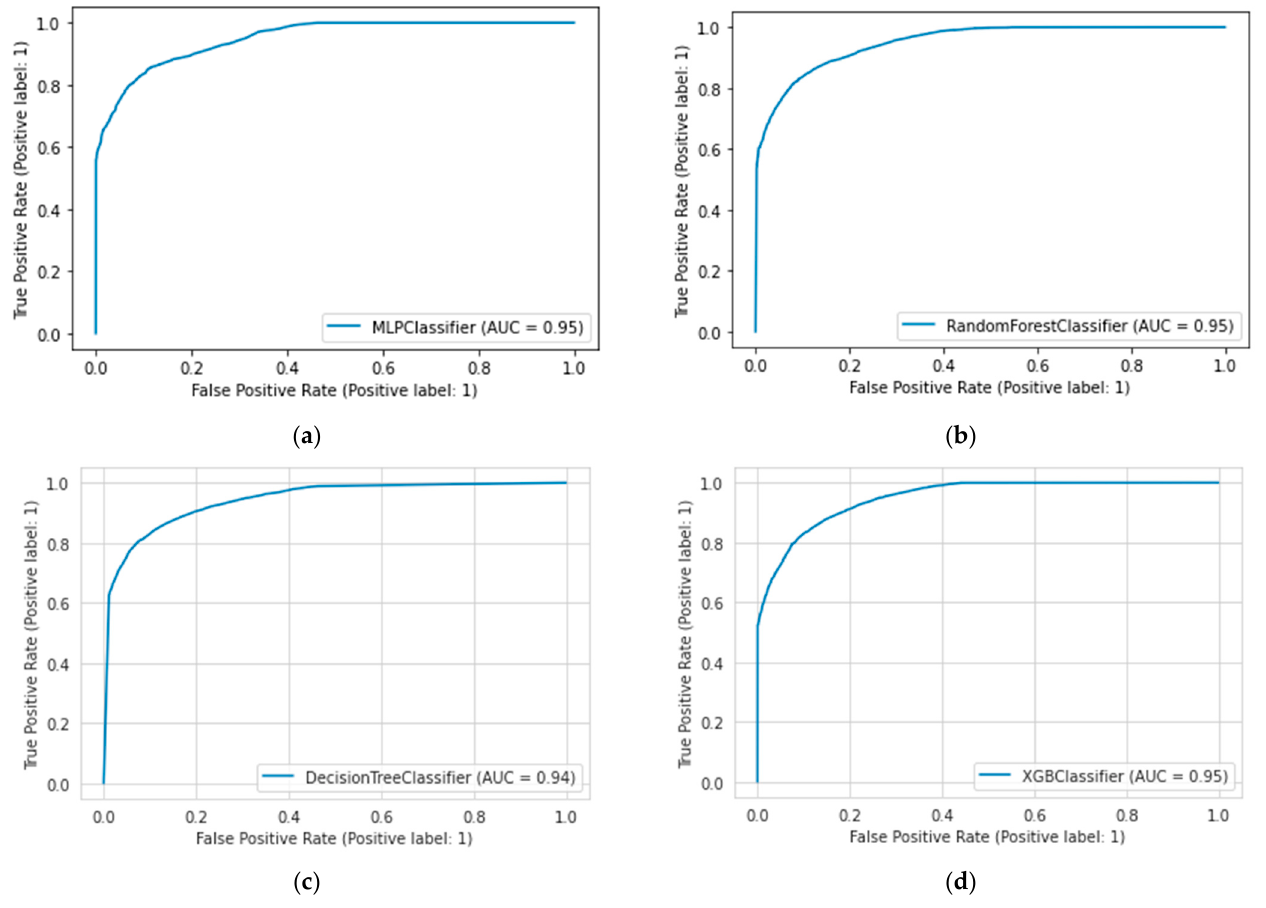
Figure 6. ROC–area under curve of ( a ) MLP, ( b ) RF, ( c ) DT, and ( d ) XGB.